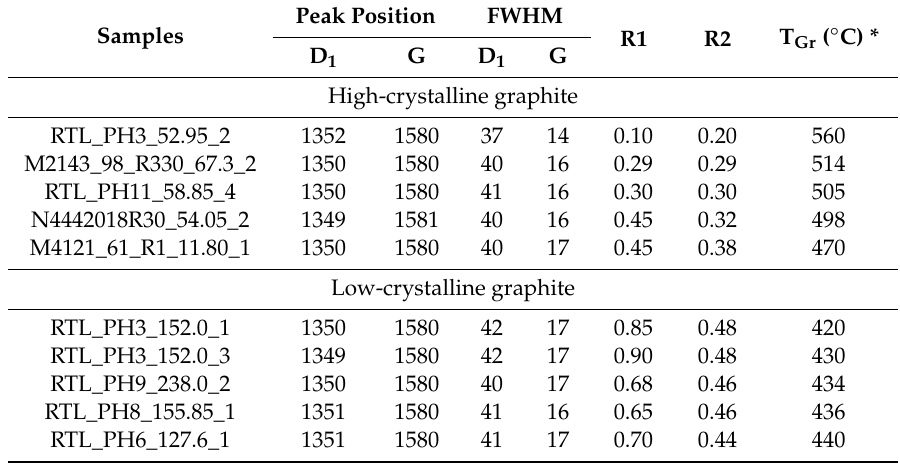
Figure 6. Temperature measurement results from Raman spectroscopy such as: ( a ) intensity ratio (R1) and area ratio (R2); ( b ) D1 and G bands positions.